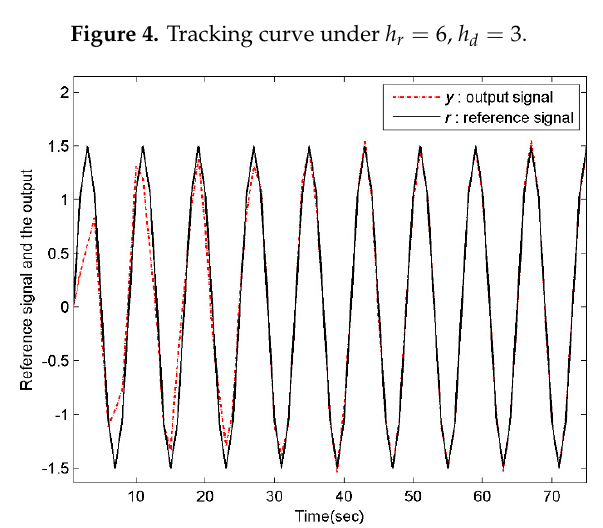
Figure 5. Tracking curve under h r = 6, h d = 15.